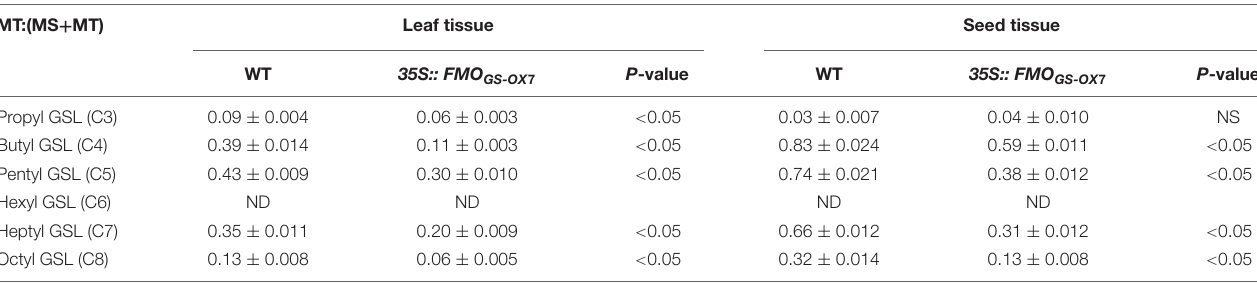
TABLE 2 | Glucosinolates profile in 35S:: FMO GS - OX 7